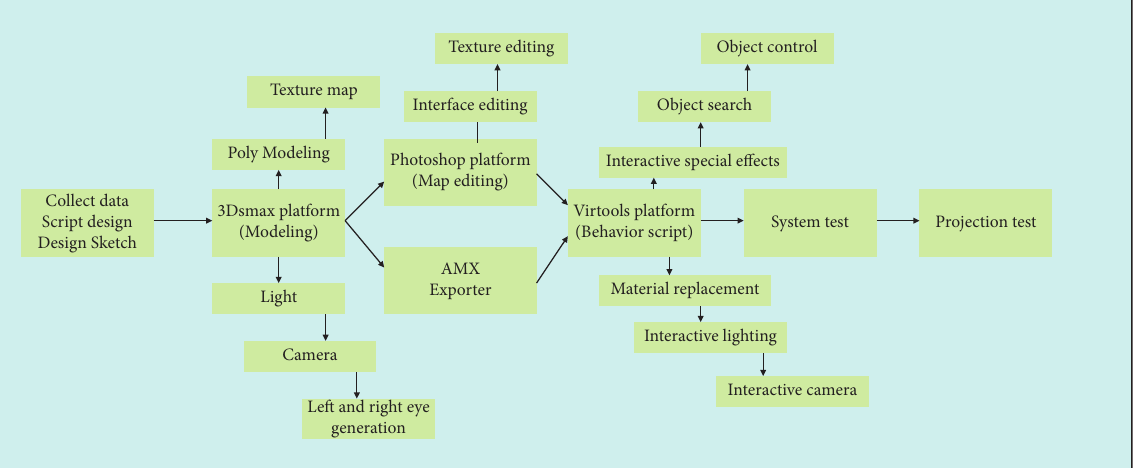
Figure 7: Procedures for software